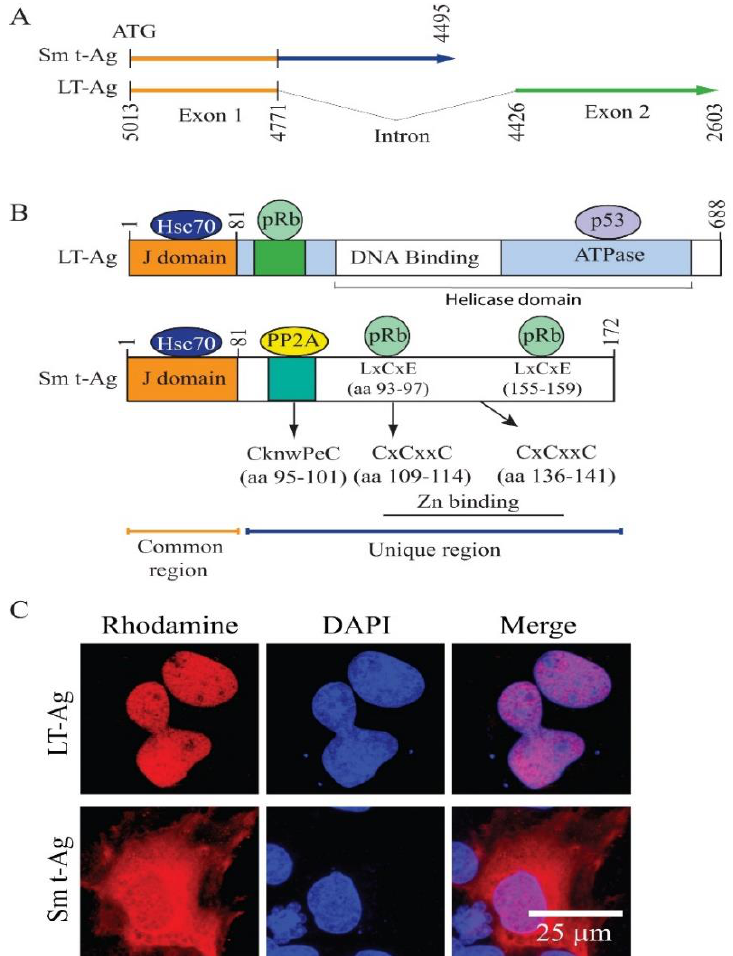
Figure 3. ( A ) Schematic representation of JCV Mad-1 early coding region. The common coding region between JCV LT-Ag and Sm t-Ag constitutes the exon 1. The unique coding regions are also indicated for each protein. Numbering is according to JCV Mad-1 strain (GenBank # NC_001699, formerly J02226). ( B ) A schematic representation of various functional domains on both LT-Ag and Sm t-Ag is indicated. Selected host protein-binding regions are also indicated for both proteins. The positions of